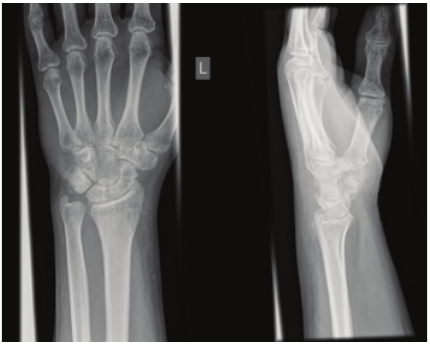
Figure 4: Radiographs at 3